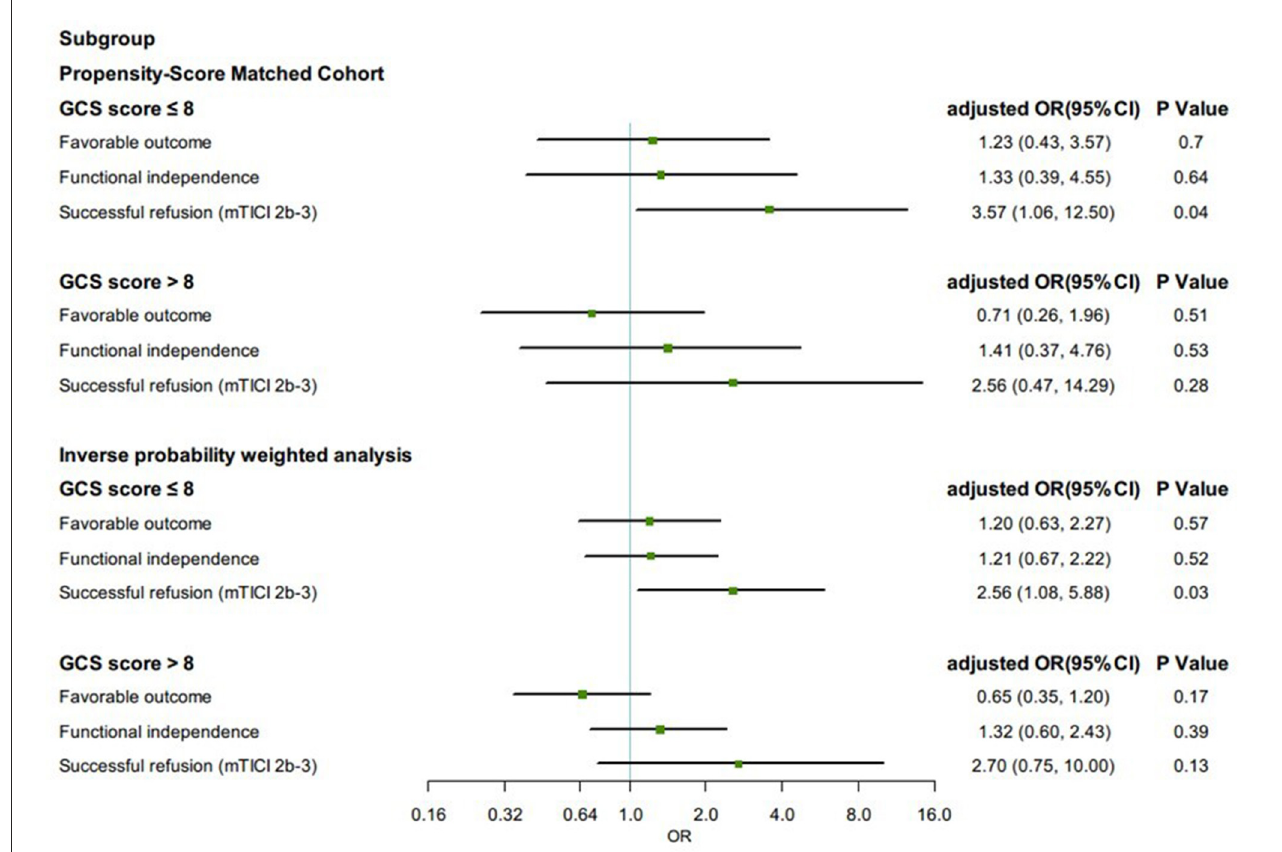
FIGURE3 Subgroup analysis in clinical and angiographic outcomes according to first-line anesthetic approach in patients treated with thrombectomy in matched and inverse probability of treatment weighting (IPTW) analyses. CI, confidence interval; mTICI, modified thrombolysis in cerebral infarction; OR, odds ratio; sICH, symptomatic intracranial hemorrhage. All regression analyses were adjusted for the following variables: age, sex, atrial fibrillation, smoking history, systolic blood pressure, glucose, site of occlusion, baseline NIH Stroke Scale score, IV thrombolysis, pneumonia, time from estimated occlusion to groin puncture, door to groin puncture, and groin puncture to